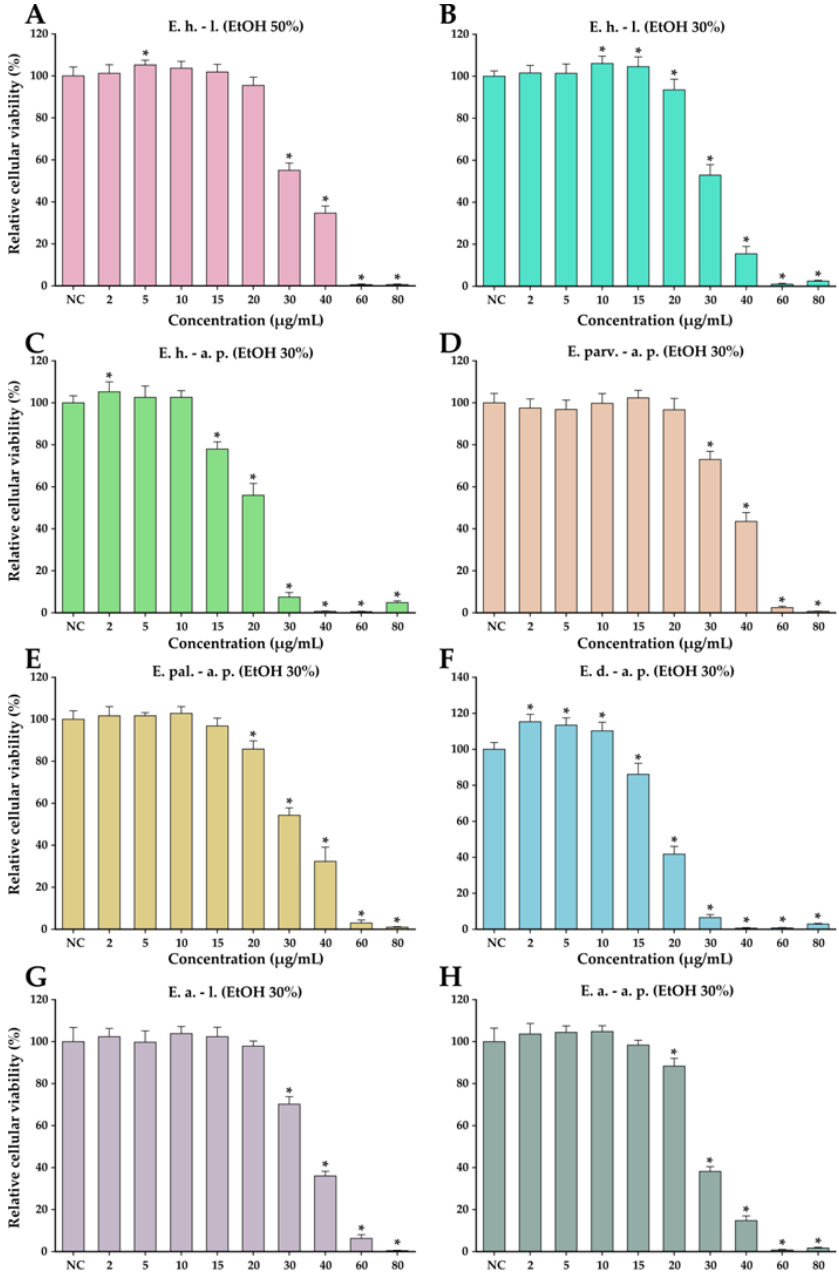
Figure 5. Cytotoxicity of E. hirsutum leaves EtOH 50% (A - E. h. – l.), E. hirsutum leaves EtOH 30% (B – E. h. – l.), E. hirsutum aerial parts EtOH 30% (C – E. h. – a.p.), E. parviflorum aerial parts EtOH 30% (D – E. parv. – a. p.), E. palustre aerial parts EtOH30% (E – E. pal. – a. p.), E. dodonaei aerial parts EtOH 30% (F – E. d. – a. p.), E. angustifolium leaves EtOH 30% (G – E. a. – l.), and E. angustifolium aerial parts EtOH 30% (H – E. a. – a. p.) evaluated using Alamar Blue assay on the LNCaP prostate carcinoma cell line after a 24 h exposure (after diluting the working solutions 1:5 in DMSO ) . The results are expressed as the means ± standard deviations of three biological replicates (each one including 6 technical replicates). The values were calculated as relative values compared to the negative control (100%). Asterisks (*) indicate statistically significant differences in comparison with negative control (ANOVA + post hoc Holm-Sidak test at p < 0.05 )